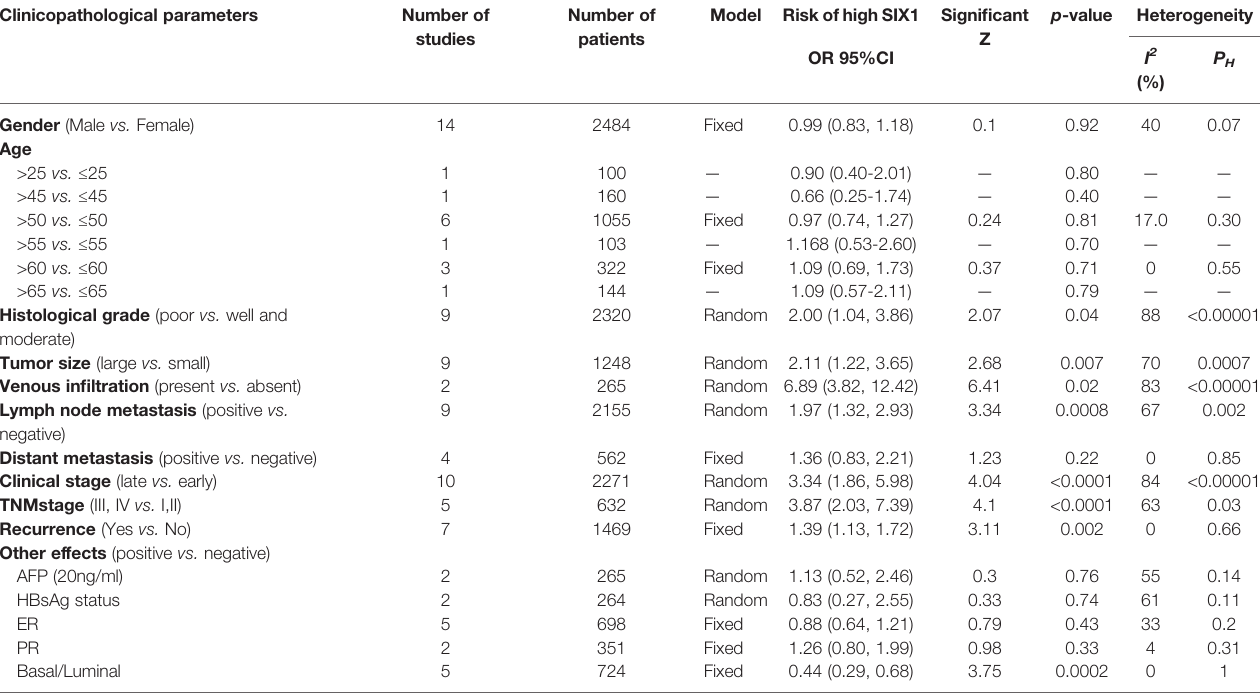
TABLE 3 | Clinicopathological features and the high expressed SIX1 in patients with cancer. Clinicopathological